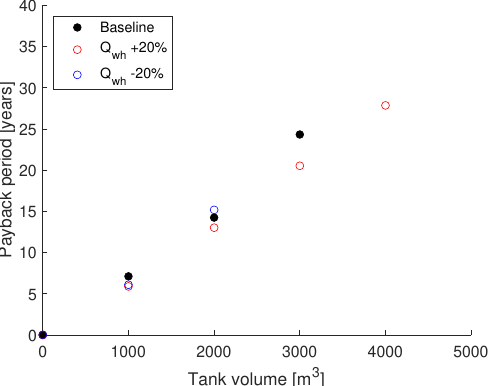
Figure 9. Payback period for Scenario 1 with variation in available waste